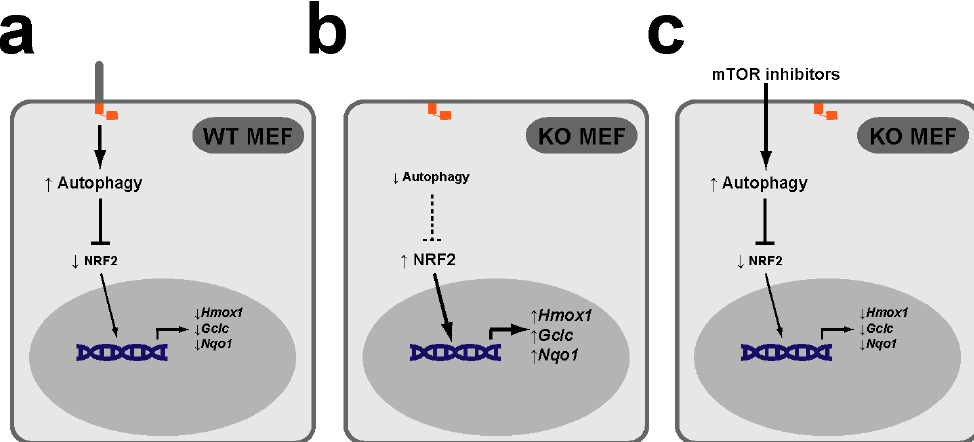
Figure 4. The PAN axis also functions in mouse embryonic fibroblasts (MEFs). ( a ) In wild type (WT) MEFs, the PAN axis functions to keep NRF2 transcriptional activity low, as reflected in low expression of NRF2 targets Hmox1 , Gclc and Nqo1 . ( b ) In MEFs KO for essential ciliogenic genes, such as Kif3a or Ift88 , lack of cilia leads to lower levels of autophagy and higher NRF2 target gene expression levels. ( c ) Treatment of KO MEFs with mTOR inhibitors rapamycin or torin-1 increases their autophagy levels and restores NRF2 target expression to normal (low) levels